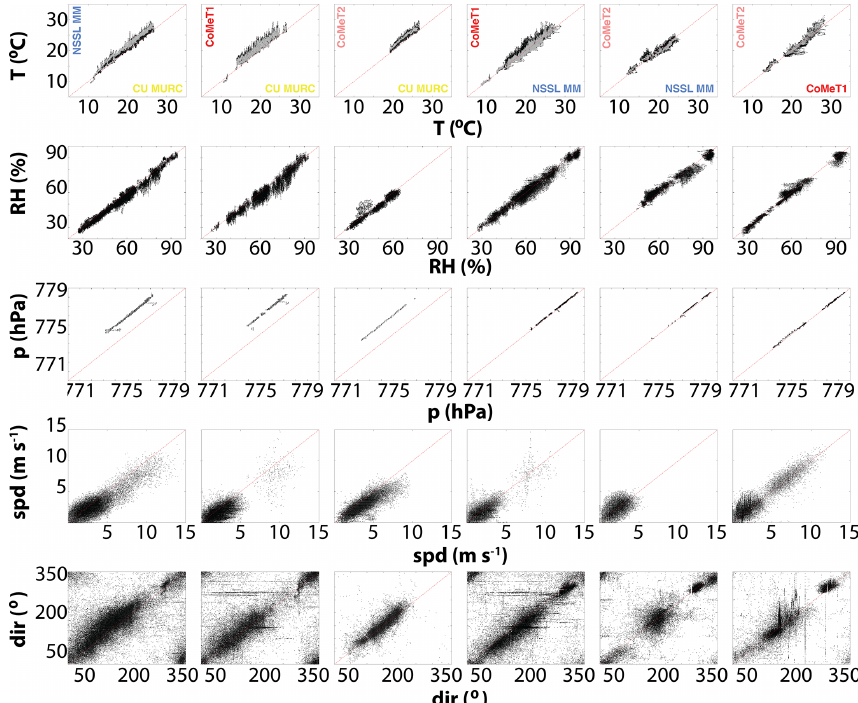
Figure 9. Vehicle-to-vehicle comparisons for time periods when vehicles were within 300m of one another. Variables evaluated include (top to bottom) temperature ( ◦ C), relative humidity (%), pressure (hPa), wind speed (ms − 1 ), and wind direction ( ◦ ). The top row includes labels to indicate which platform is on which axis, and these orientations are maintained through each column. For the temperature comparisons (top row), both the slow (dark dots) and fast (lighter dots) temperature sensors are